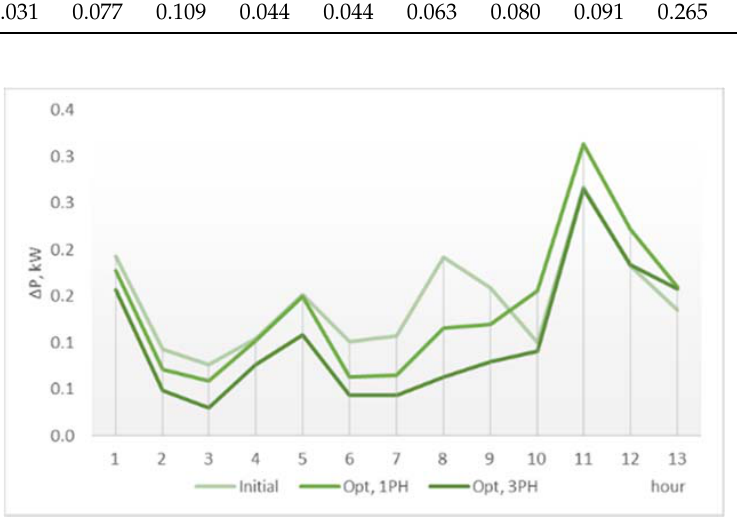
Figure 19. Hourly losses in network R121.